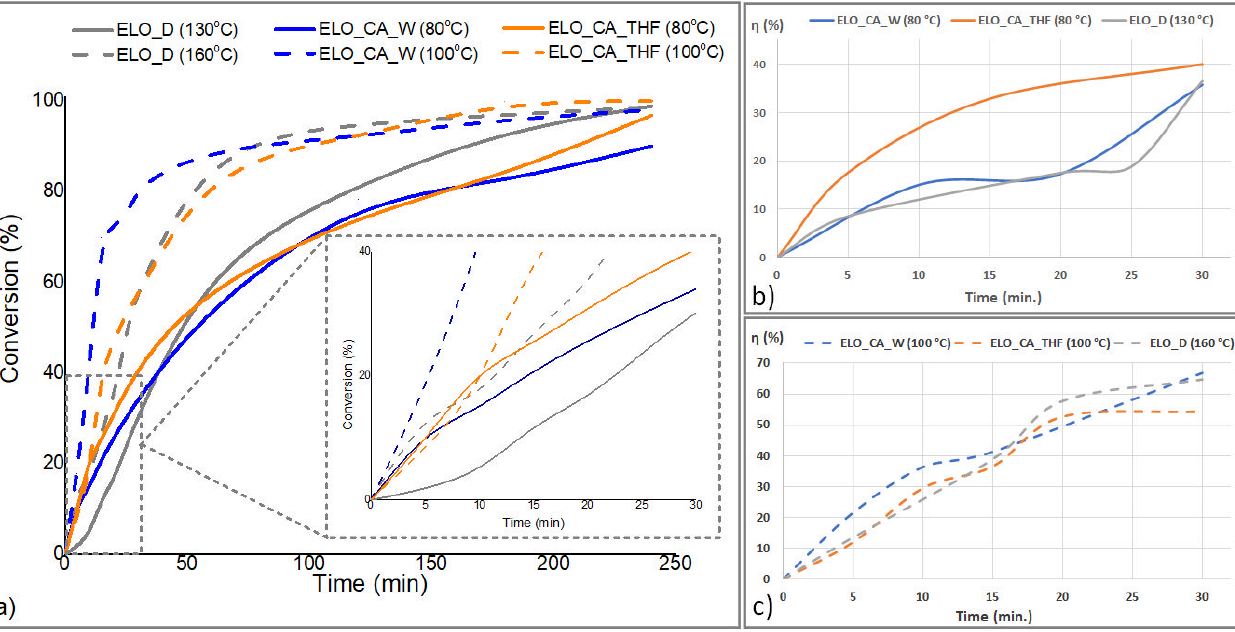
Figure 4. Curing kinetics calculated for ELO ‐ based systems by DSC at different temperatures ( a ) and from the FTIR spectra in the first 30 min. of reaction, at lower temperatures ( b ) and higher temperatures ( c ).